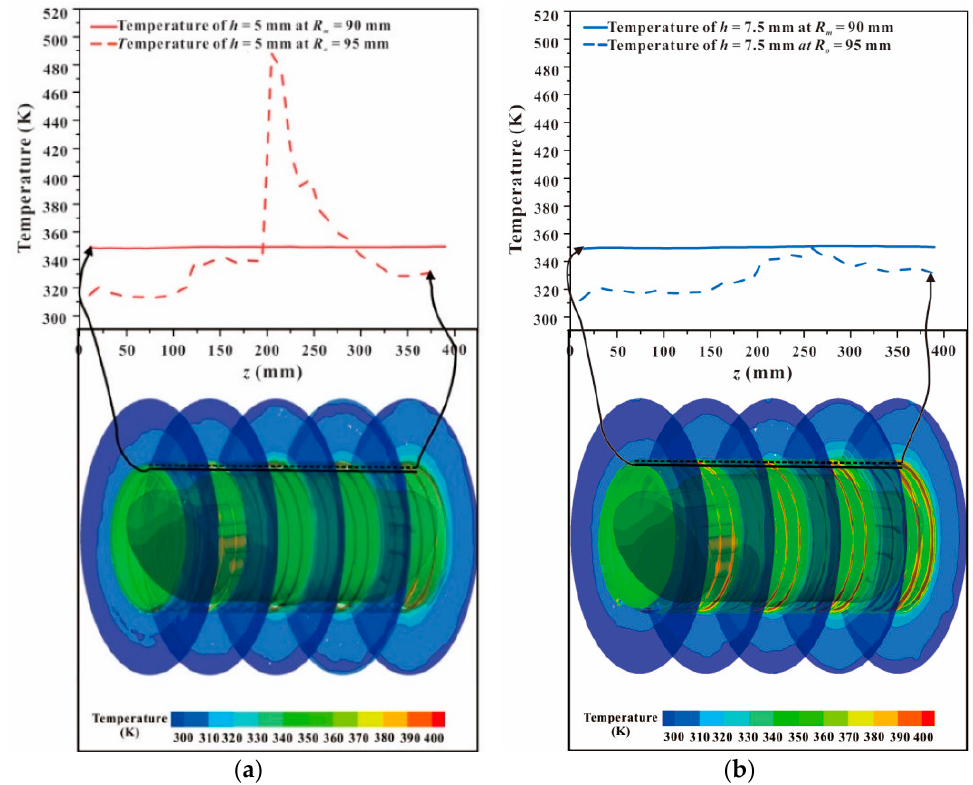
Figure 8. Temperature distribution with a fin pitch p = 20 mm and fin thickness t = 2 mm when ( a ) fin height h = 5 mm; ( b ) height = 7.5 mm.